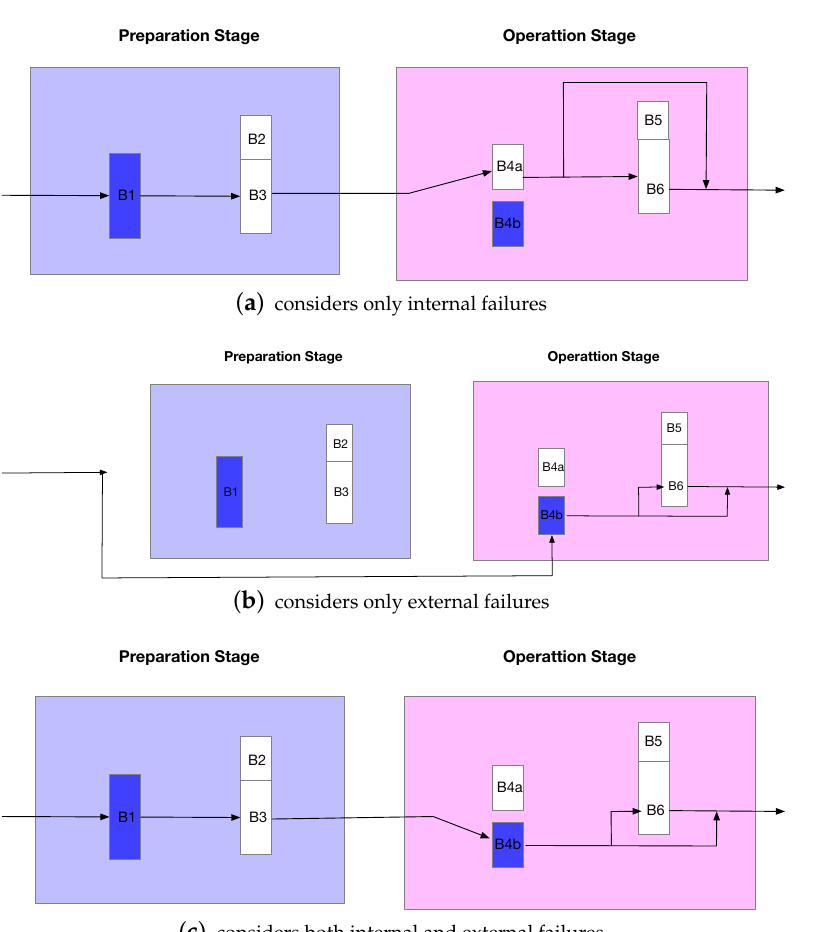
Figure 6. Graphical models under the different scenarios (please refer to Tables 1 and 3 for the meanings of the